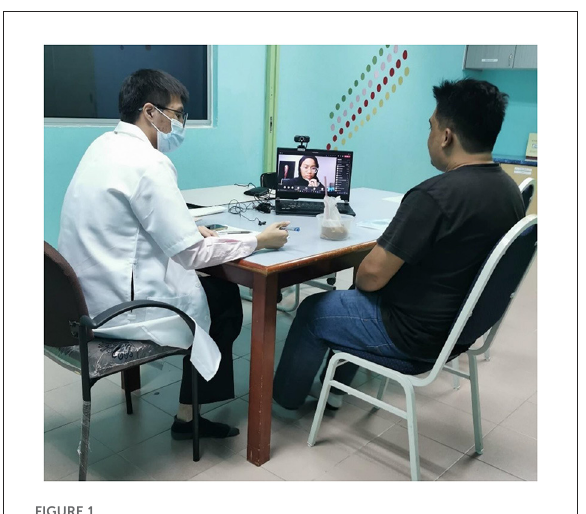
FIGURE1 Example of clinical set-up onsite and online synchronous